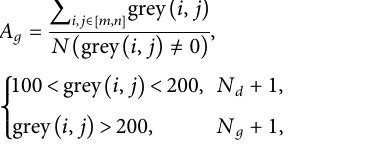
FIGURE 7 Comparison of detection accuracy.